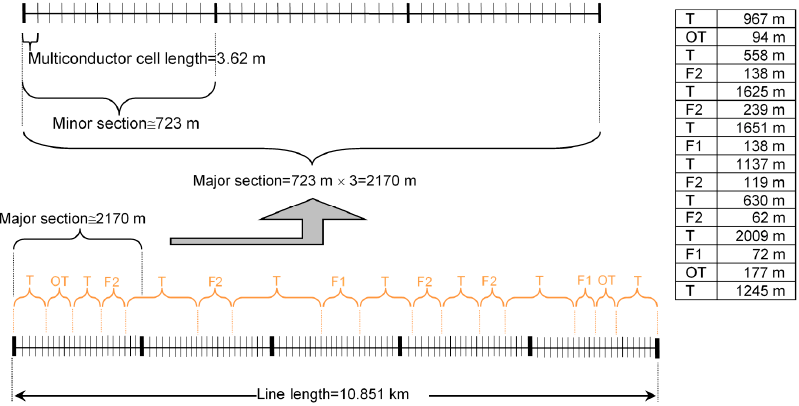
Figure 9. Subdivision of case #3 in elementary cells, minor and major sections. OT—open trefoil with spacing = 0.18 m; F1—flat laying with spacing = 0.25 m; F2—flat laying with spacing = 0.5 m; T—close trefoil.